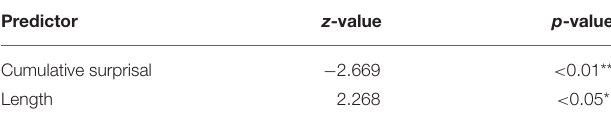
long on average. The mean surprisal values vary between 2.91 and 4.09. The minimum mean surprisal value is the smallest in our corpus (2.91).